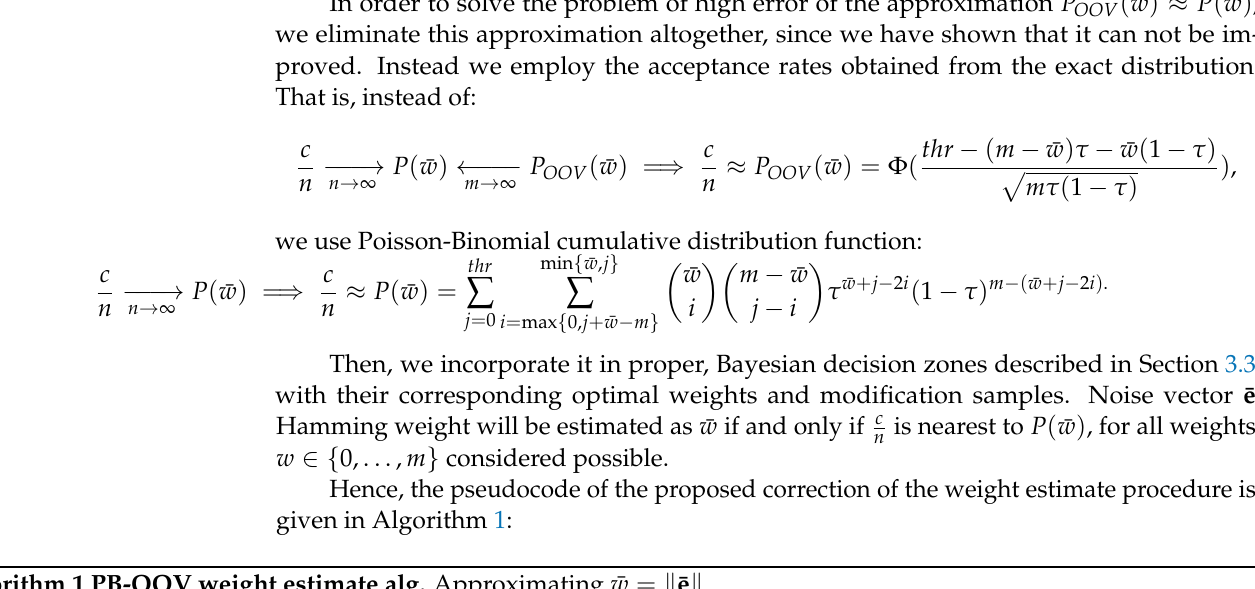
Algorithm 1 PB-OOV weight estimate alg. Approximating ¯ w = (cid:107) ¯e